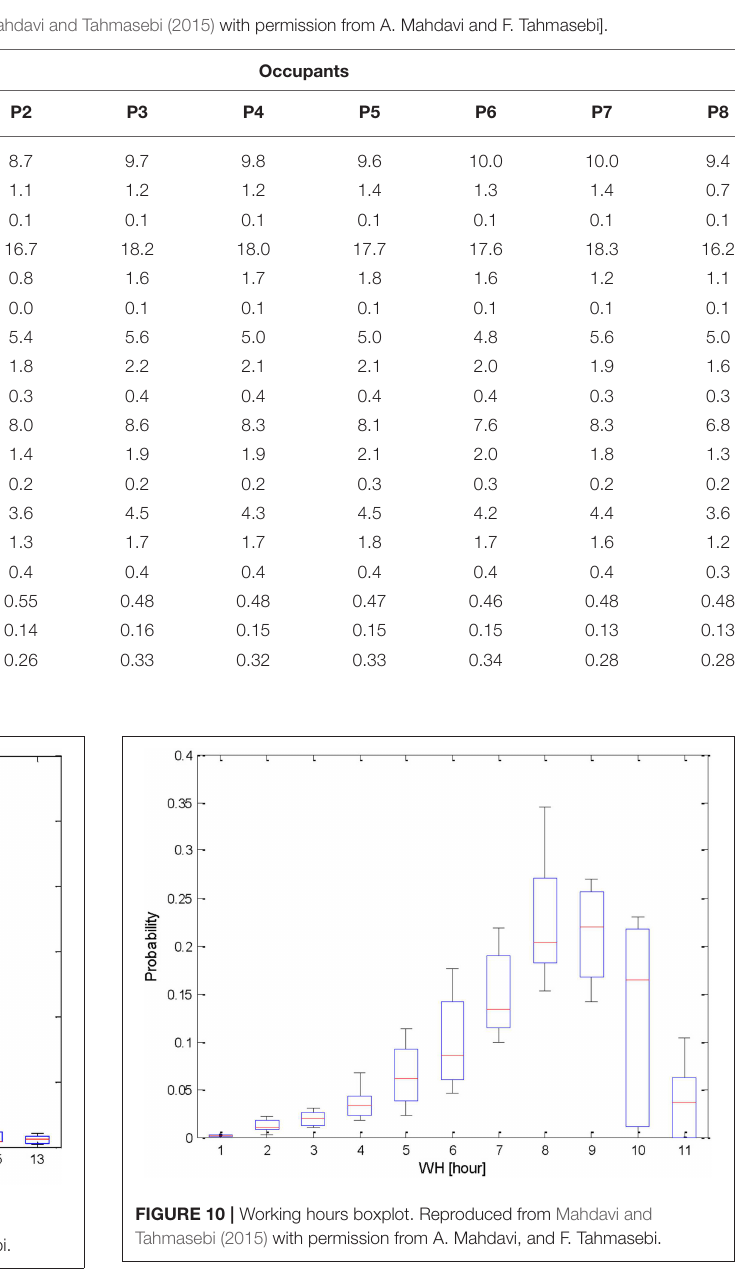
(as expressed in the values of the statistics considered),